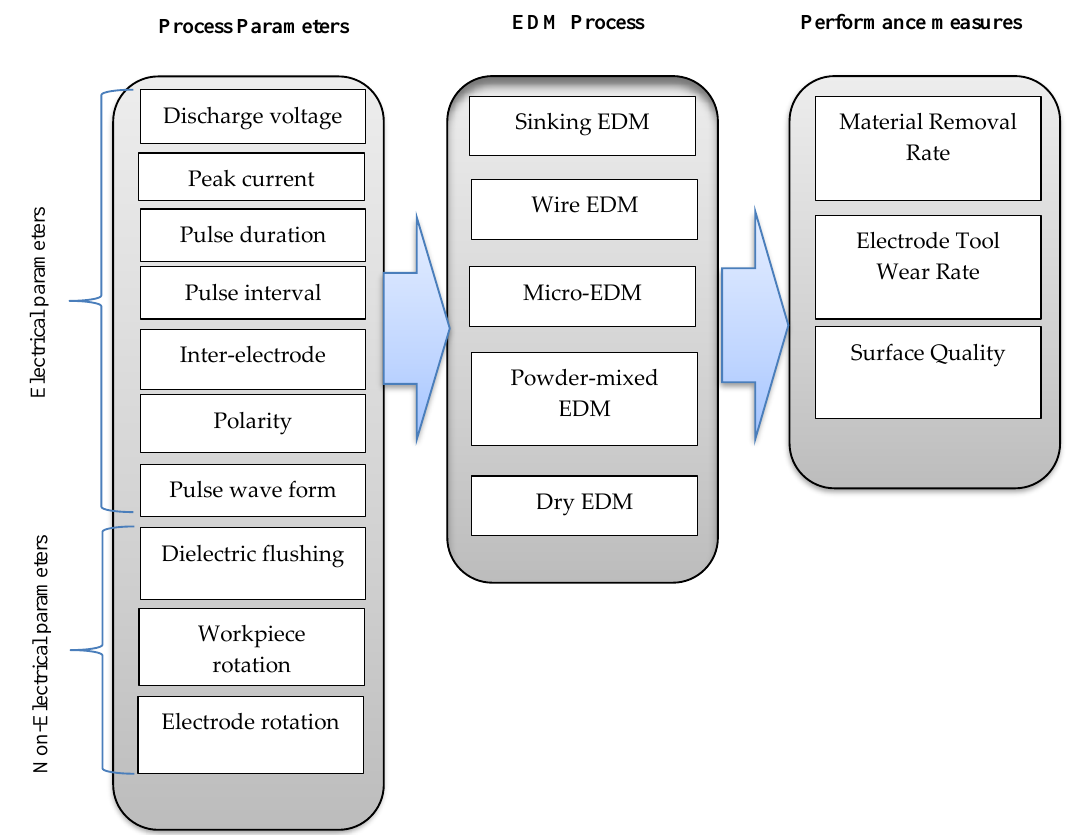
Figure 1. Electric discharge machining (EDM) processes, process parameters and performance measures .